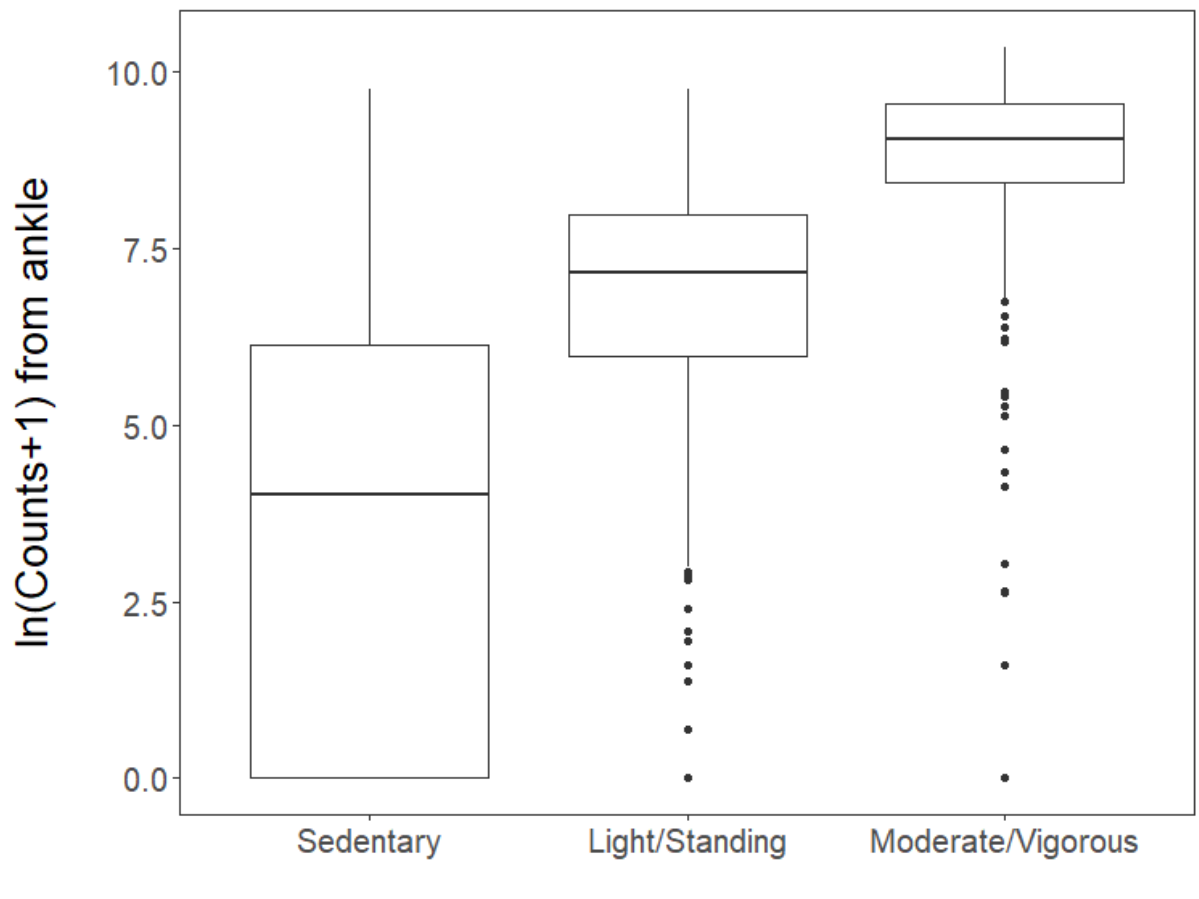
Figure 4. μEMA responses versus ln(Counts +